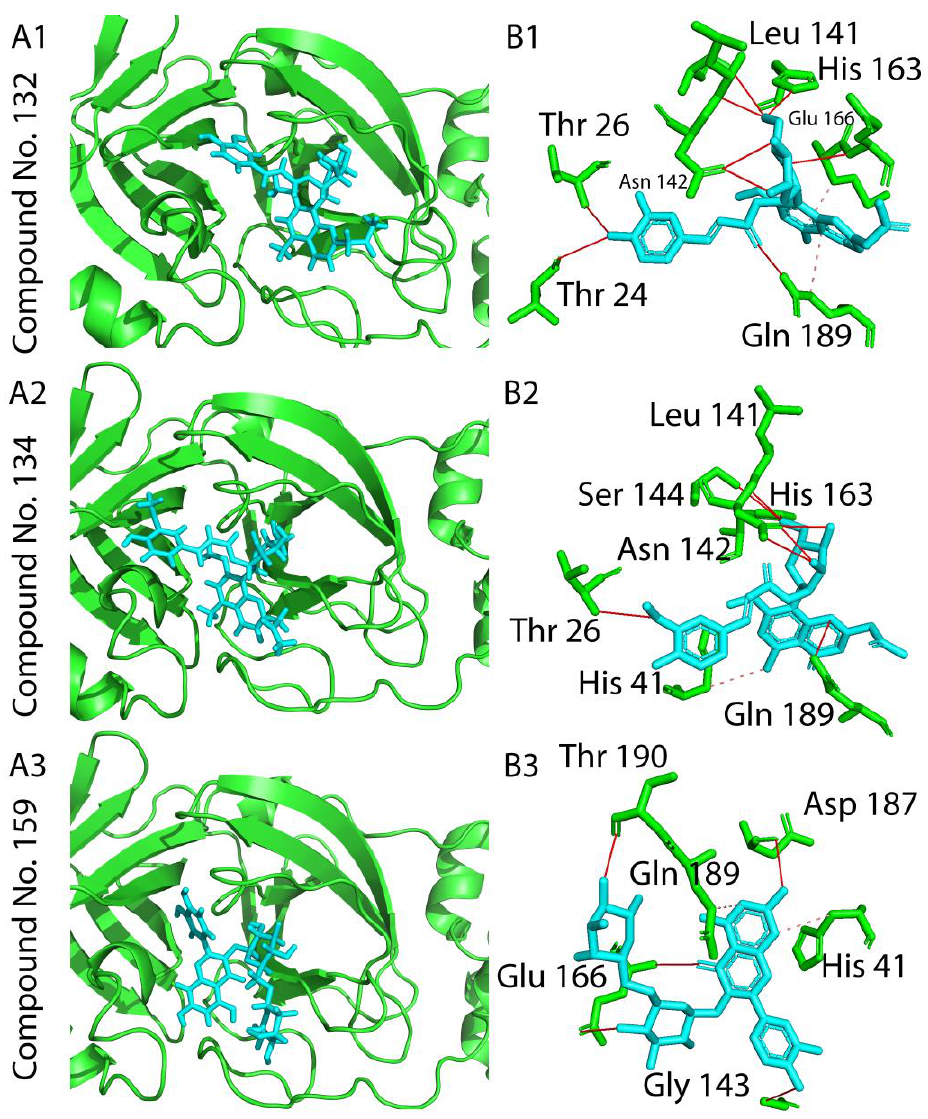
Figure 6. 2D and 3D docking interactions complexes of compounds; 132 ( A1 , B1 ), 134 ( A2 , B2 ) and 159 ( A3 , B3 ) with SARS-CoV-2 main protease protein M pro . Solid red line: Hydrogen bonds. Dashed pink line: Hydrophobic interactions. Table 1. Molecular docking results and interactions of the three top scoring compounds of Aloe species with SARS-CoV-2 proteins.